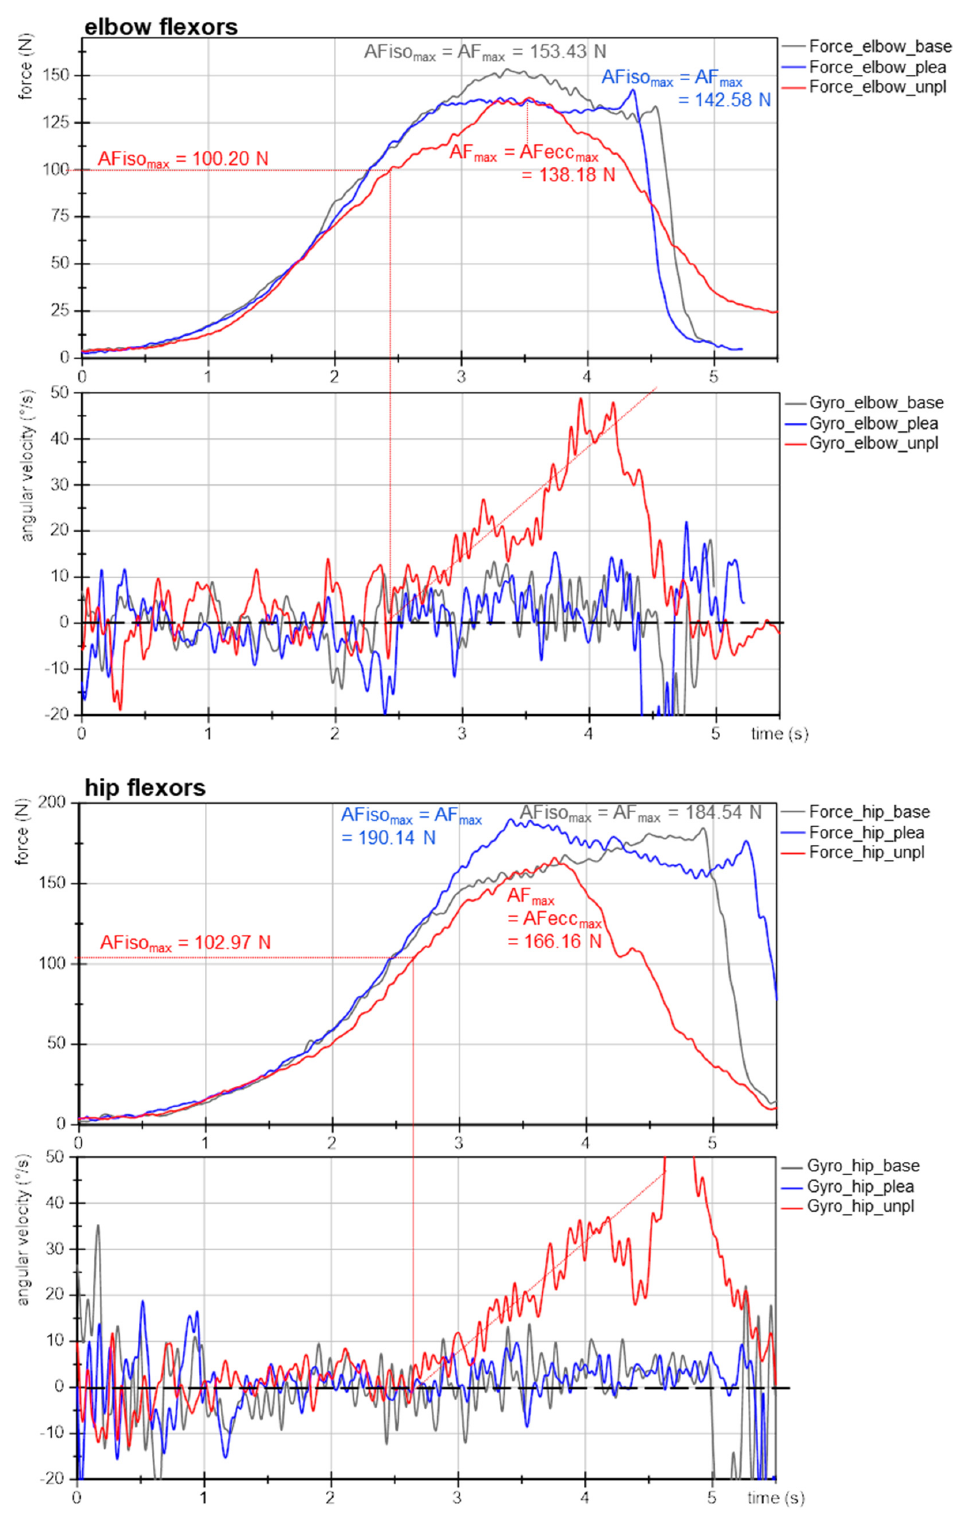
Figure 3. Exemplary signals of Adaptive Force during MMT. Displayed are force (N) and gyrometer signals (°/s) during MMT of elbow and hip flexors of the same participant (age: 22 years, height: 171 cm, body mass: 63 kg) for baseline (grey, base), pleasant (blue; plea) and unpleasant (red; unpl) imagery. Parameters AF max , AFecc max and AFiso max are marked.